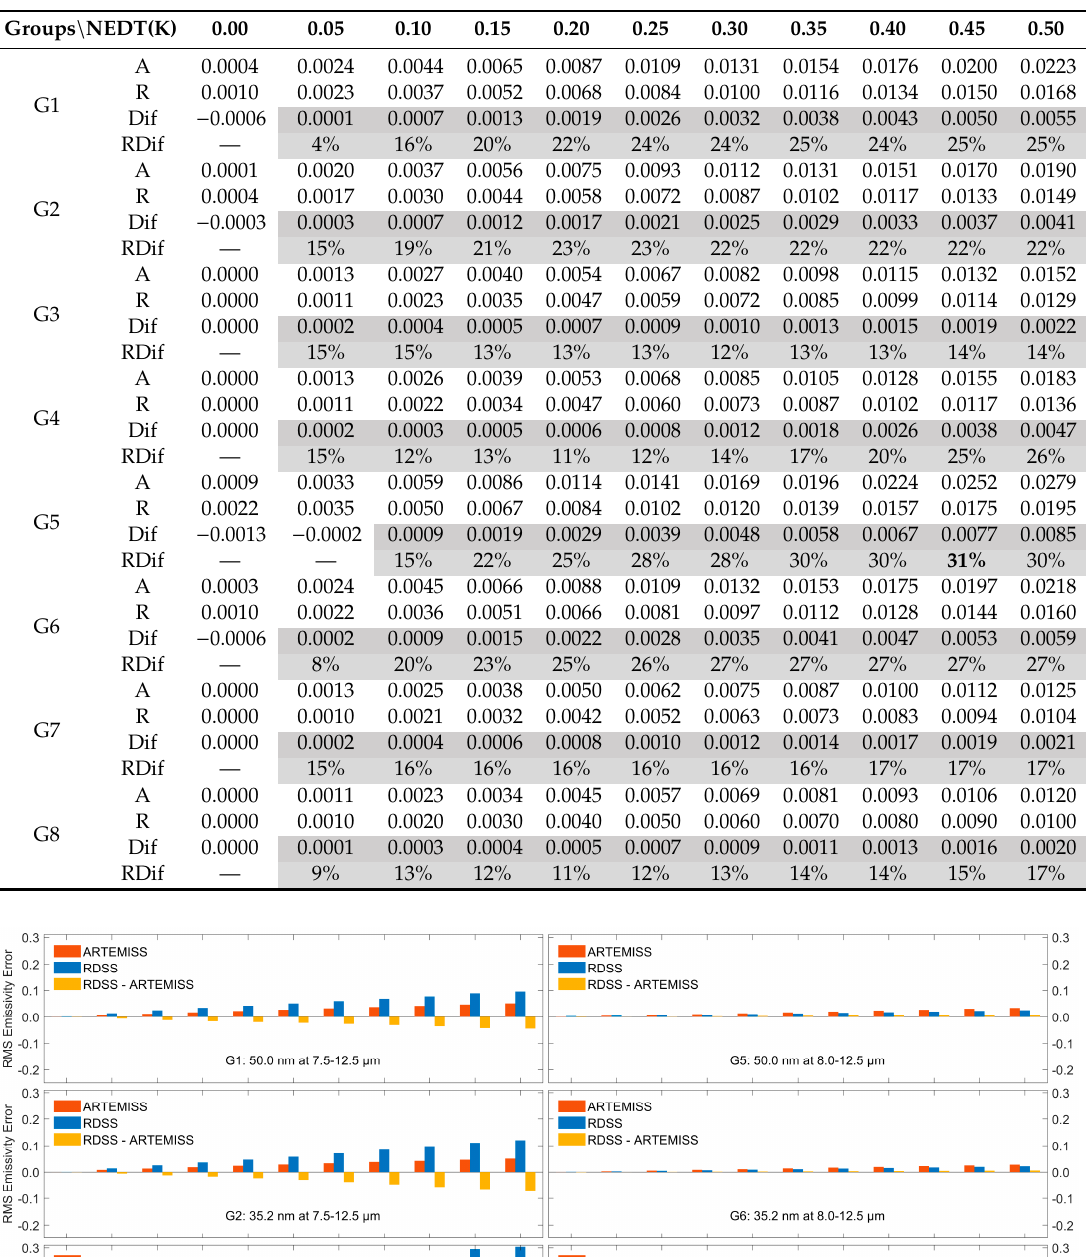
Table 5. The retrieved LSE MAD for the RDSS and ARTEMISS algorithms and their di ff erences. Groups \ NEDT(K)